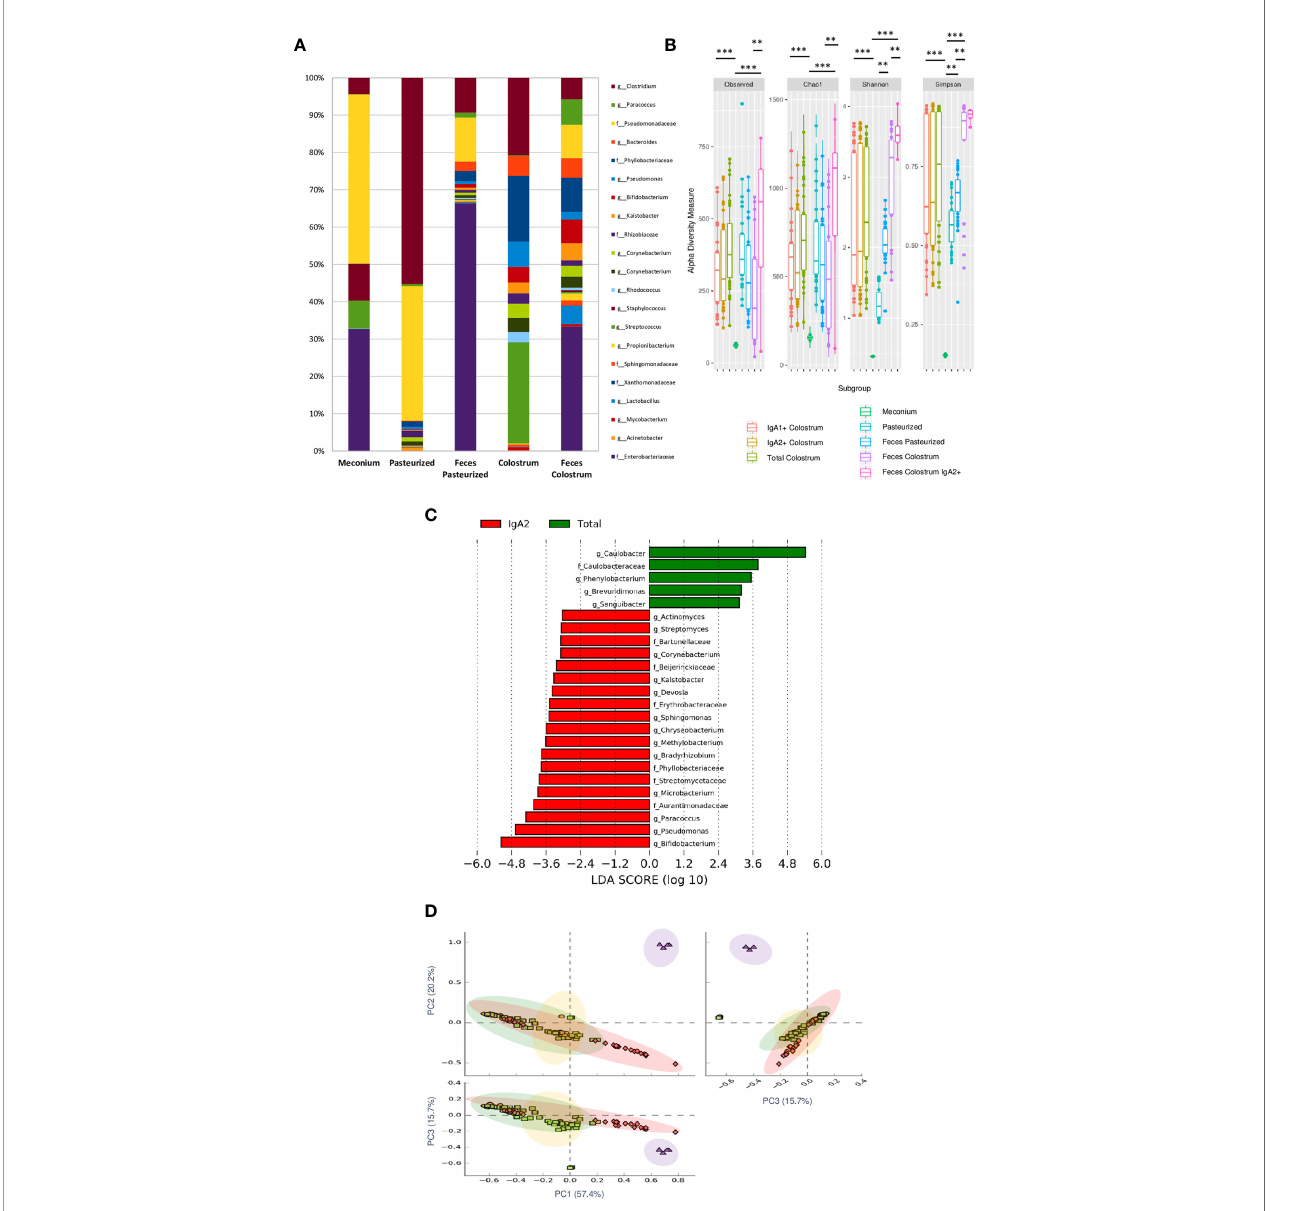
FIGURE 4 | IgA2+ microbiota is present in fecal neonate ’ s samples. (A) Relative abundance of predominant bacterial taxa in stool samples (Meconium, neonates fed with pasteurized milk= “ Pasteurized, ” neonates fed with pasteurized milk= “ Feces Pasteurized ” and neonates fed with colostrum= “ Feces Colostrum ” ; during fi rst three days of life). The abundance of each family/genera in IgA fractions was compared between groups using a parametric test for paired samples followed by BH correction. (B) Alpha diversity based in observed number of species (p < 0.001), Chao1 (p < 0.001), Shannon (p < 0.001) and Simpson (p = 0.006) indexes. Mann- Whitney U test was used to fi nd signi fi cant differences. Alpha diversity based on observed number species (p < 0.001), Chao1 (p < 0.001), Shannon (p < 0.001) and Simpson (p < 0.005) indexes. Mann – Whitney U test was used to fi nd signi fi cant differences **p < 0.01, ***p < 0.001. (C) LEfSe analysis of the most representative bacterial genera in stool samples. Linear discriminant analysis (LDA) effect size (LEfSe) comparison of differentially abundant bacterial taxa among free fecal bacteria ( “ Total ” ) and IgA2+ fecal bacteria ( “ IgA2 ” ); from neonates whose were fed with colostrum during the fi rst three days of life. Horizontal bars represent each taxon ’ s effect size: red indicates taxa enriched in the IgA2+ fraction group, and green indicates free taxa enriched group. LDA score cutoff of 2.4 was used to discriminate bacterial taxon. Previous graphs represent data from fi ve “ Meconium ” , twenty-eight “ Pasteurized milk ” , twenty-seven “ Feces pasteurized ” , thirty-six “ Total colostrum ” , thirty “ IgA1+ colostrum ” , thirty-three “ IgA2+ colostrum ” , nineteen “ Feces Colostrum ” and fi ve “ IgA2+ Feces ” samples. (D) Two dimensional scatterplots were generated using PCoA based on the unweighted UniFrac distance metric. PC3 vs PC2, PC1 vs PC2, and PC1 vs PC3. Both groups signi fi cantly differed according to the ANOSIM similarity test (R 2 = 0.289, p = 0.001) and Adonis statistical test (R 2 = 0.949, p = 0.001). Total bacteria from colostrum samples are represented in red diamonds, IgA2+ fecal bacteria from neonates fed with colostrum in green squares, total bacteria from neonates fed colostrum in yellow circles, and total bacteria from pasteurized milk in purple